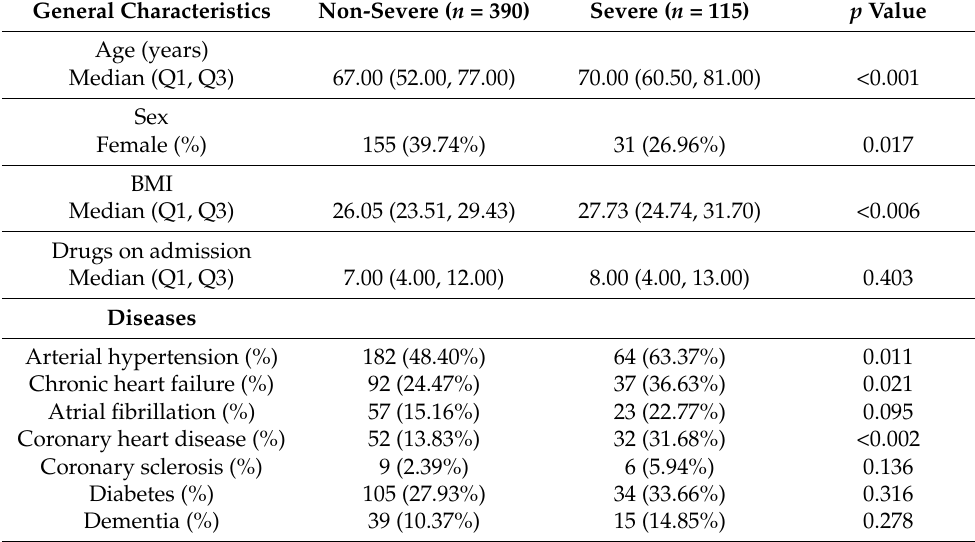
Table 1. Characteristics of study